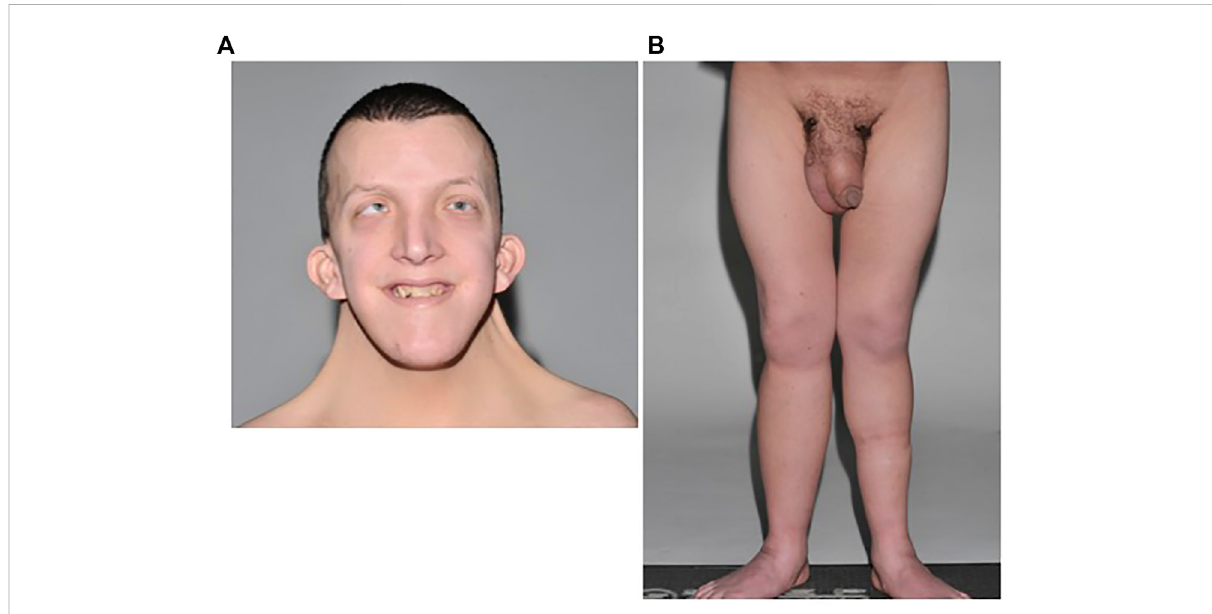
FIGURE 2 Patient A: (A) Heavy T2 weighted coronal MRI image demonstrating moderate left sided pleural effusion (wide white arrow) and soft tissue oedema (narrow white arrow). (B) Post contrast MRI coronal MIP image demonstrating bilateral fl ow of contrast from the inguinal lymph nodes into the retroperitoneal lymphatics and up into the distal thoracic duct. (C) Termination of the thoracic duct at the level of the carina (white arrow) at the siteofsurgicalligation.Nosinglepointofdrainageintotheterminalthoracicductfromtheabdomenisidenti fi ed.Noleakageofcontrastisseen into the pleural